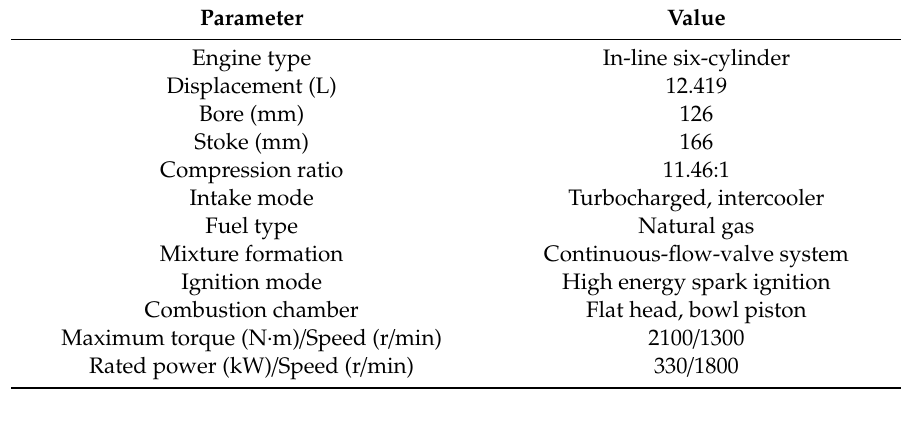
Table 1. Specifications of tested engine.